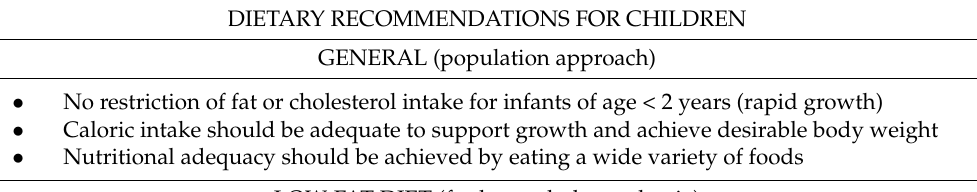
Table 1. Dietary recommendations for children with hypercholesterolemia, modified from Giovan- nini M. et al.